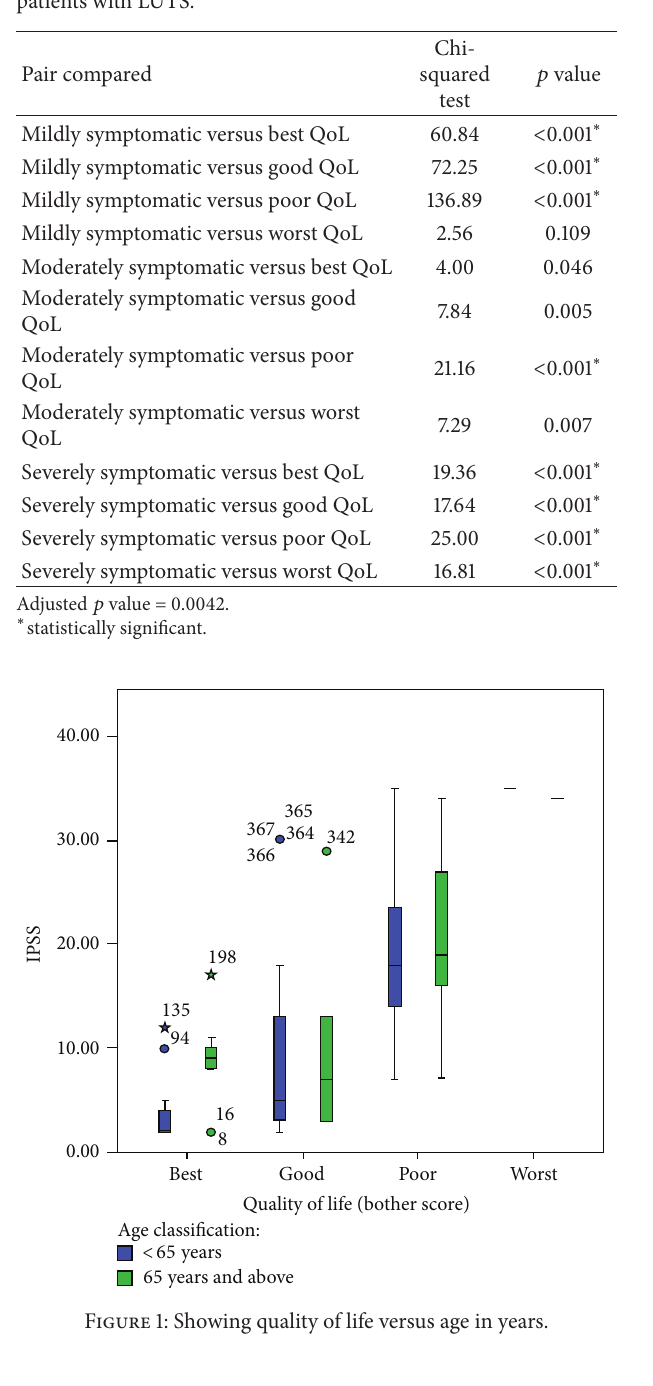
Table 4: Pairwise comparison of IPSS severity and quality of life of patients with LUTS.